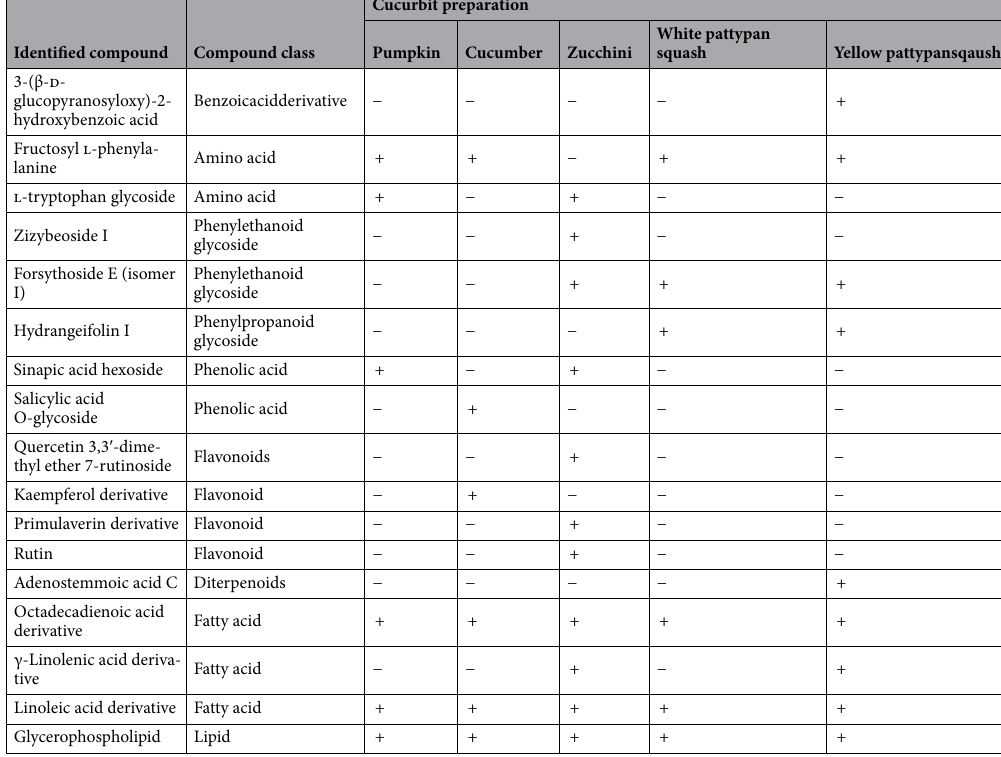
Table 1. Identified compounds and their presence (+) in five cucurbit vegetable preparations based on Rolnik et al. 10